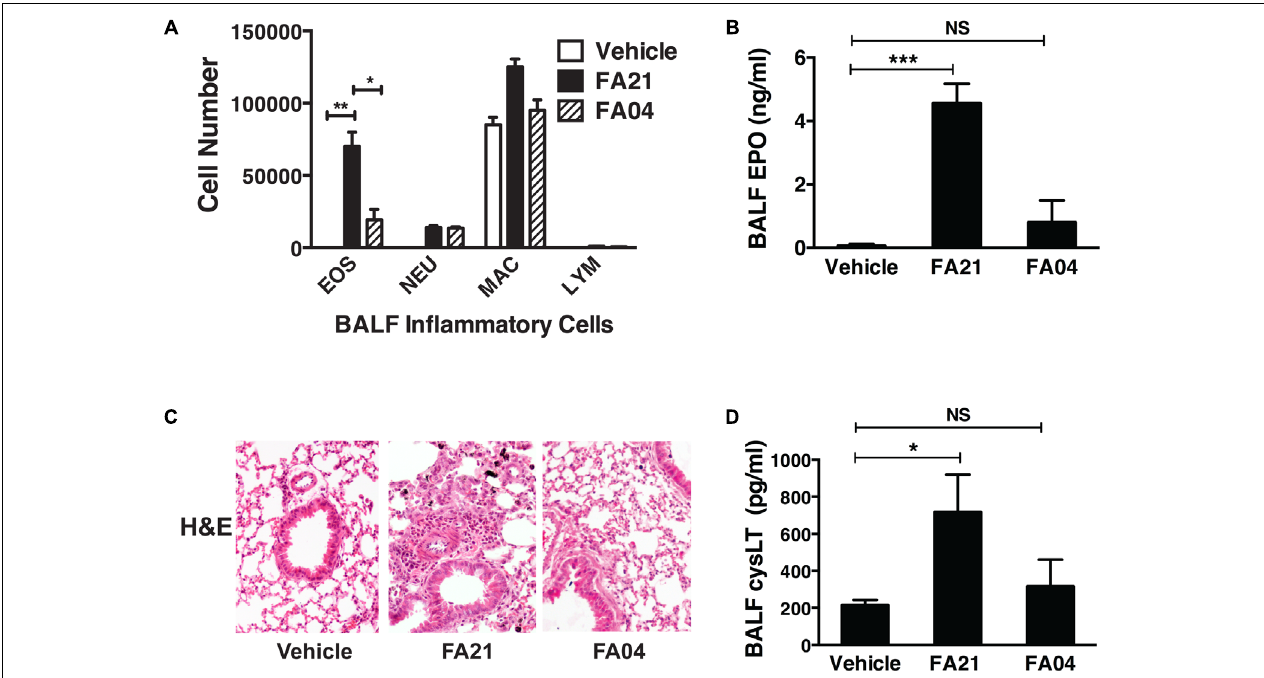
FIGURE 6 | Comparison of the level of pulmonary inflammation elicited by exposure to MWCNT with high or low nickel content. The effect of nickel on the inflammatory process was investigated by comparing the airway inflammation elicited by exposure to MWCNT with high (FA21) or low (FA04) nickel content. C57BL/6 mice (four mice per group) were given vehicle alone (control), FA21 or FA04 (50 µ g of MWCNT) by oropharyngeal instillation into the lungs and BALF was collected 24 h after exposure. (A) The level of pulmonary inflammation was determined by BALF cell differential counts and expressed as absolute cell numbers per mouse of lymphocytes (LYM), macrophages (MAC), eosinophils (EOS), and polymorphonuclear neutrophils (NEU). (B) BALF cell-associated EPO activity was measured using colorimetric analysis. (C) Lung inflammation was determined by histological analysis of H&E-stained tissue collected 24 h after vehicle, FA21 or